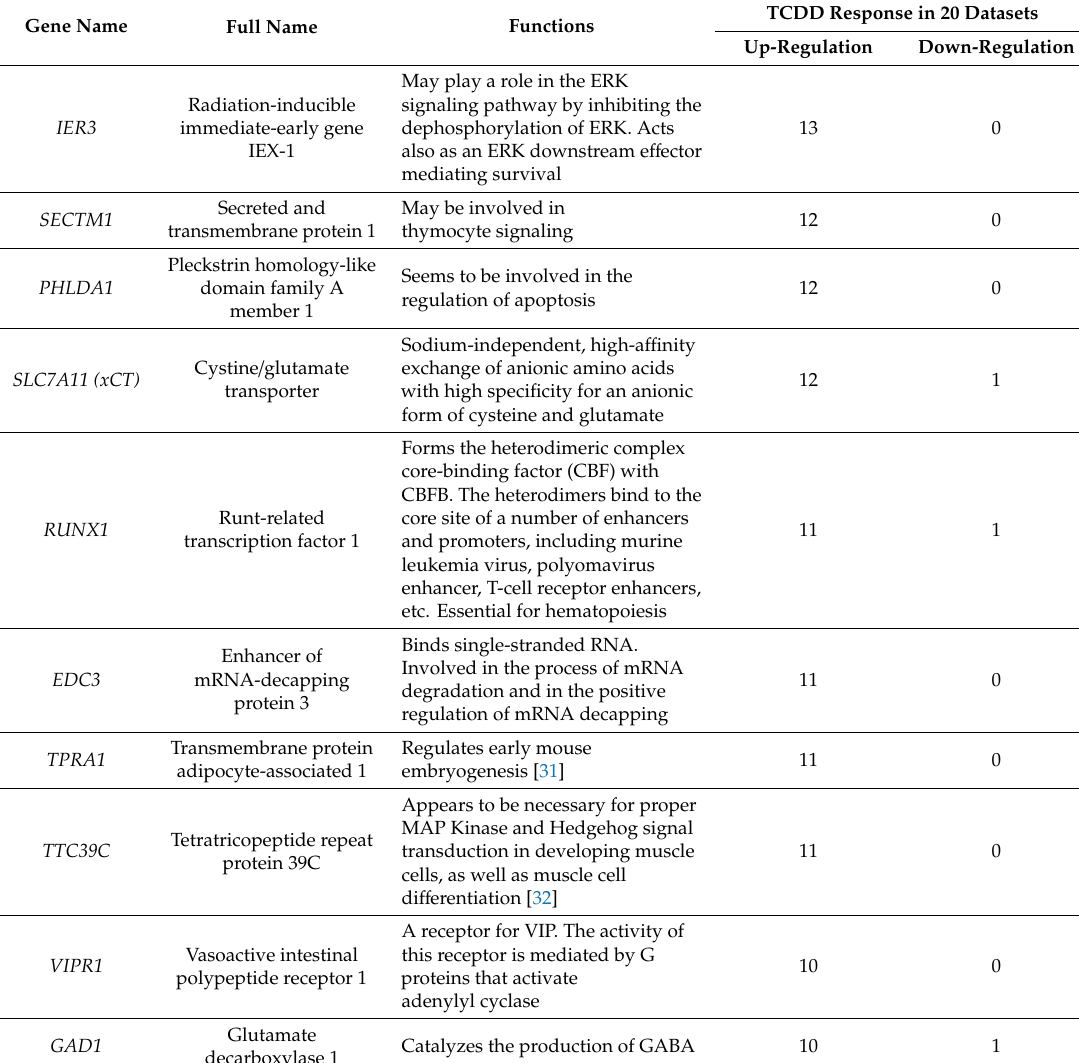
Table 3. The most robustly a ff ected genes in response to TCDD that were not previously known to be associated with the AhR pathway. The gene function annotations were taken from the UniProtKB [24]. All genes are robustly